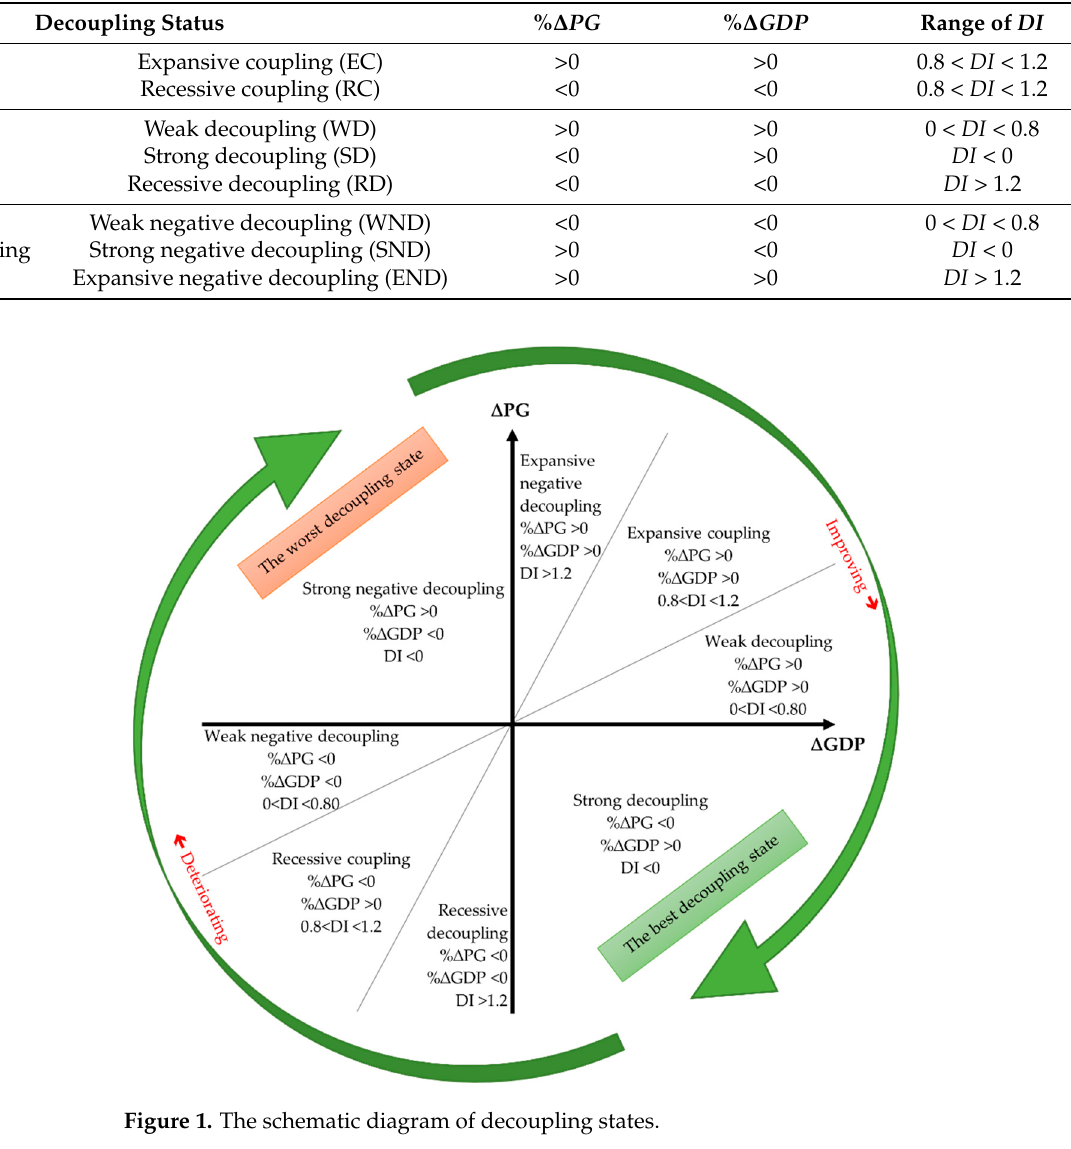
Table 2. Criteria for Defining the Decoupling Status.